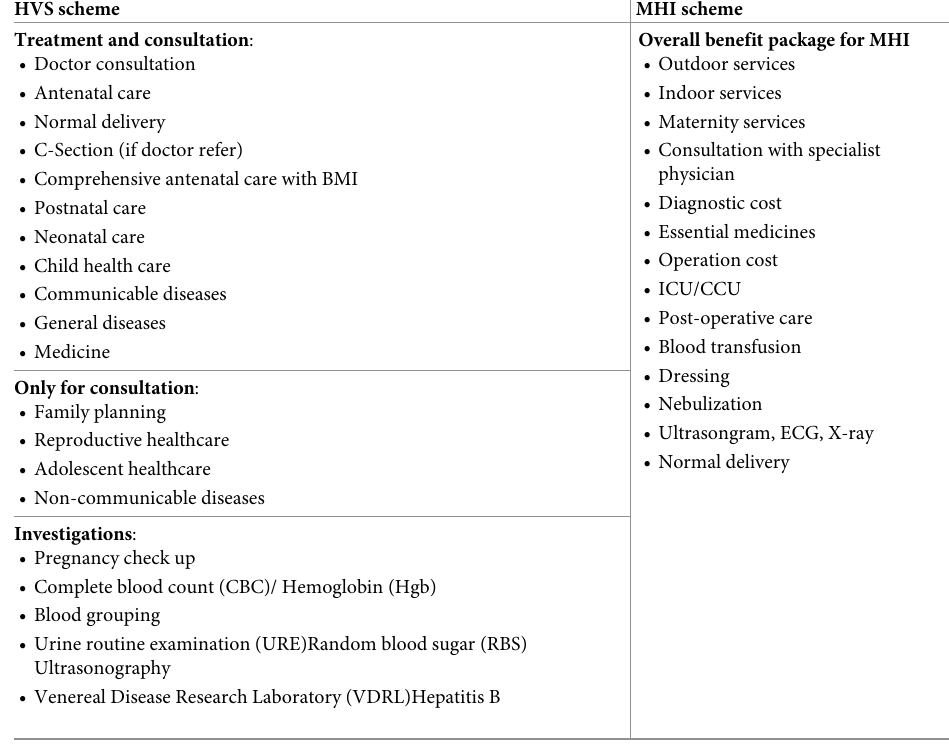
Table 1. Benefits package for enrolees of HVS